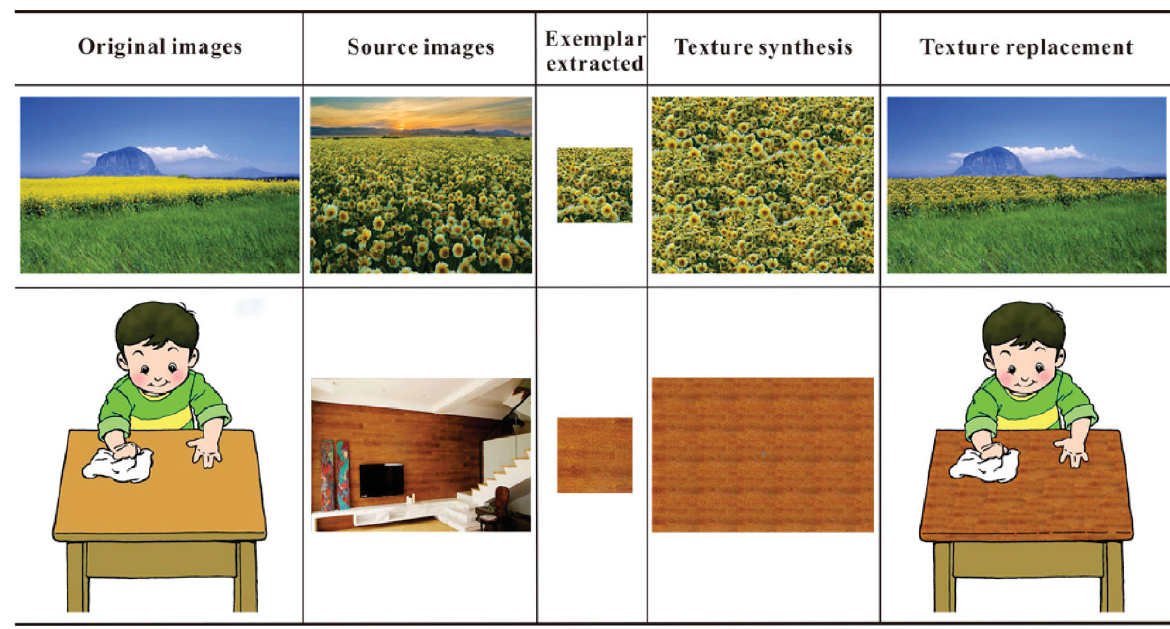
Fig. 11 Applications of texture synthesis and replacements using our extracted texture exemplars.